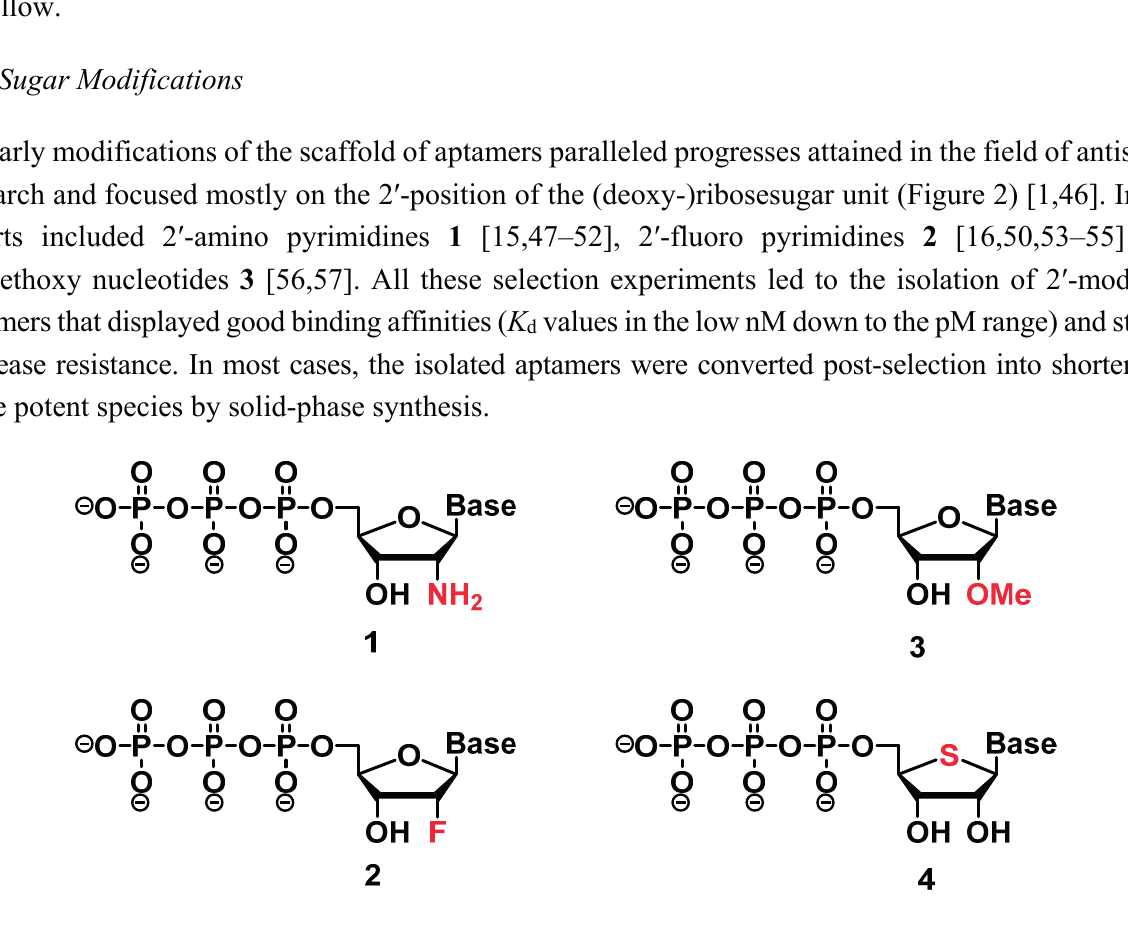
Figure 2. Chemical structures of 2 ′ -modified nucleotides used in selection experiments to generate aptamers with enhanced pharmacokinetic properties: 2 ′ -amino-NTPs 1 , 2 ′ -fluoro-NTPs 2 , 2 ′ -methoxy-NTPs 3 , and 4 ′ -thio-NTPs 4